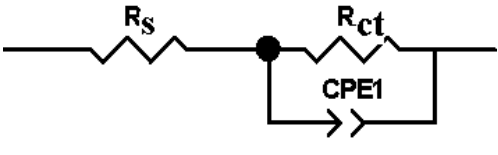
Figure 11. Equivalent circuit.